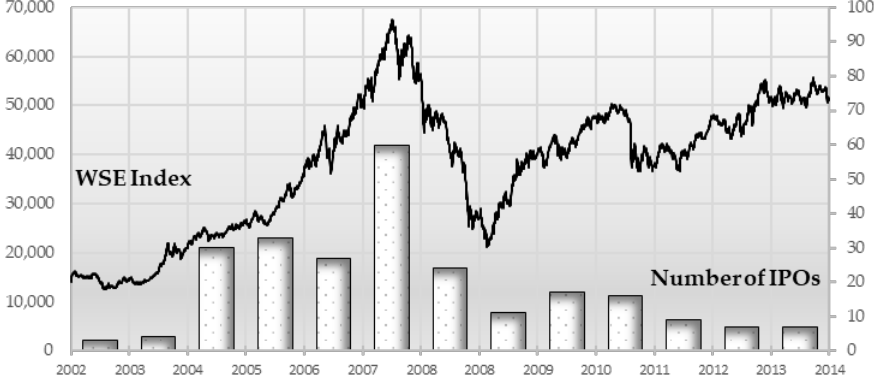
Figure 1. IPO activity and market situation.